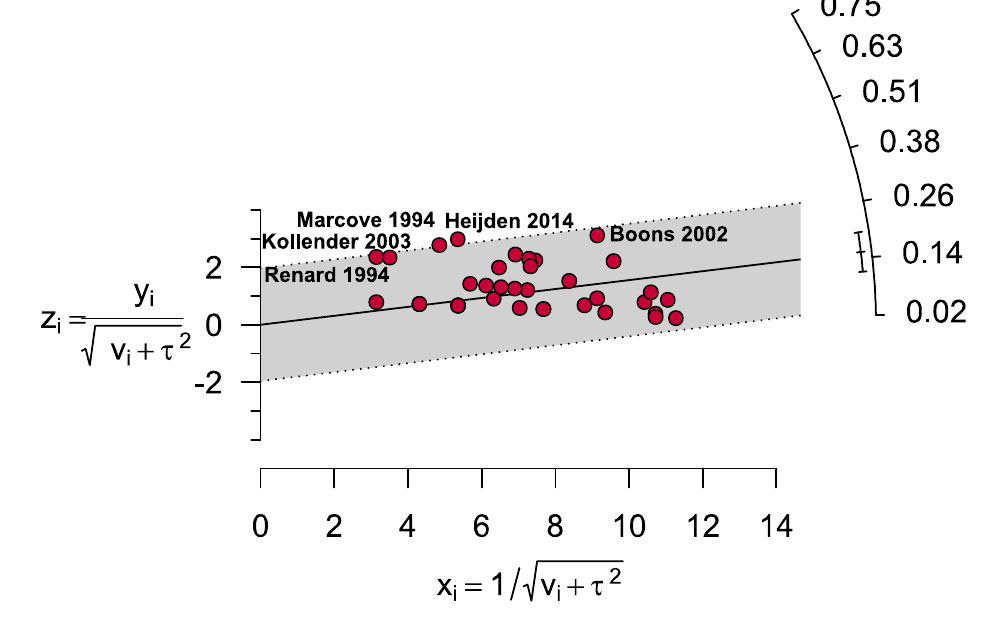
Figure 5. Galbraith's plot identified five outlier studies. Figure 5. Galbraith’s plot identified five outlier